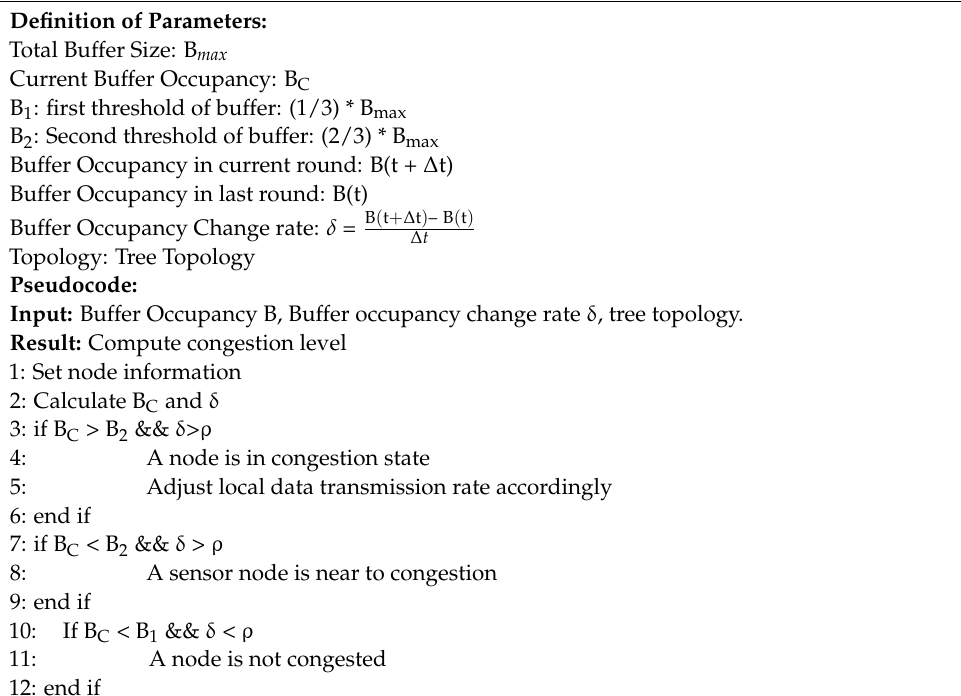
Algorithm 1: Pseudo-code of proposed DPCC algorithm for tree topology.